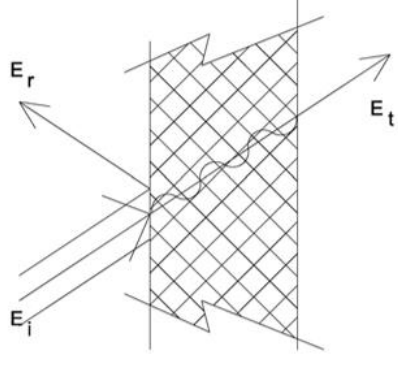
Figure 5. Diagram of sound intensities.